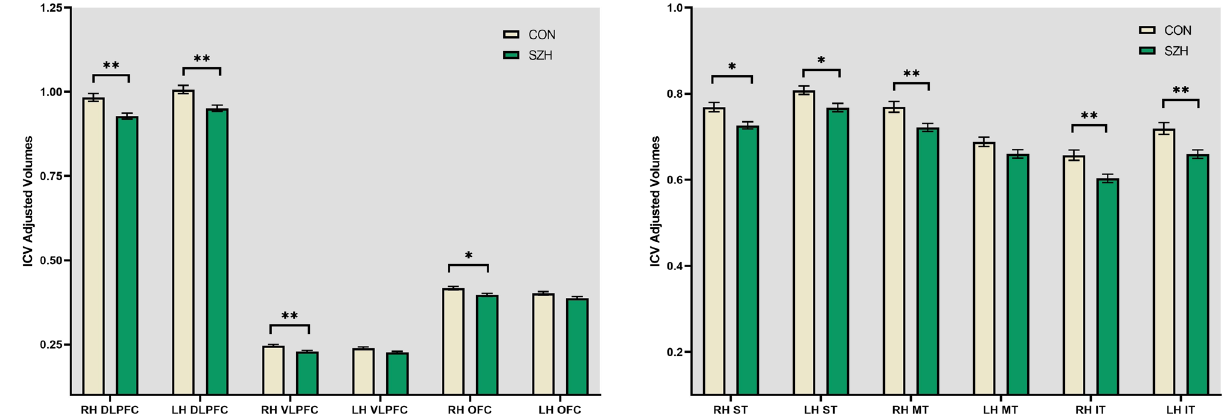
Fig. 2 Group differences in ICV-Adjusted Volumes between Controls (CON) and Schizophrenia Patients (SZH). RH right hemisphere, LH left hemisphere, DLPFC dorsolateral prefrontal cortex, VLPFC ventrolateral prefrontal cortex, OFC orbitofrontal cortex, ST superior temporal, MT middle temporal, IT inferior temporal. **p < 0. 01 , *p < 0. 05